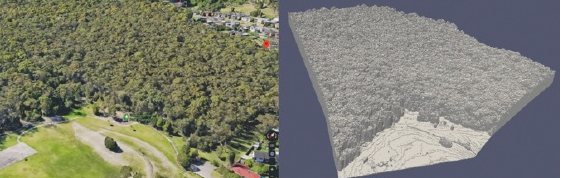
Figure 5: Study area as visualised in Google Earth (left) and voxelised point cloud